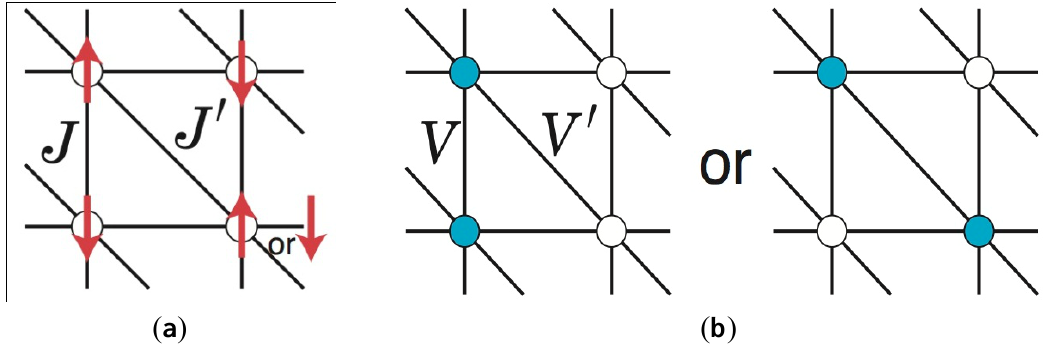
Figure 4. Frustrated lattices in ( a ) spins (arrows) and ( b ) charges (shaded